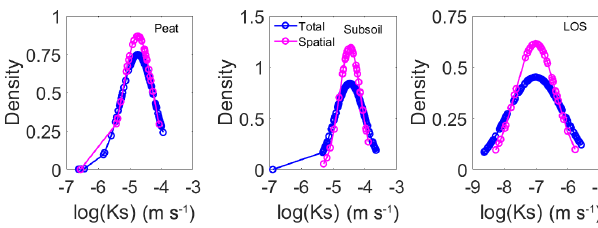
Figure 5. PDFs of K s total (spatial plus temporal) variability and spatial variability for the three